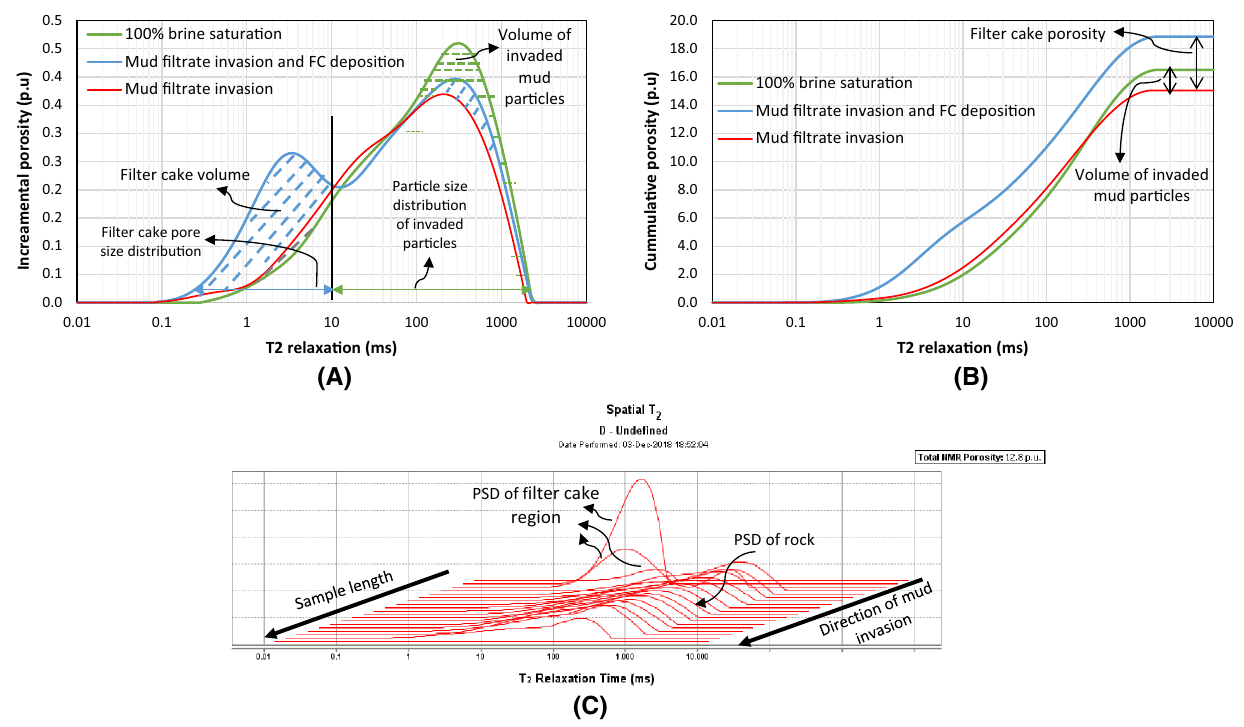
Fig. 10 Sample 4 A PDF of NMR T responding cumulative pore sizes (porosity) for the different sample 2 relaxation showing the pore size states. C Spatial pore size distribution along the sample length distribution at 100% KCl saturation (green), after mud invasion and filter cake deposition (blue), and after removal of filter cake. B Cor-